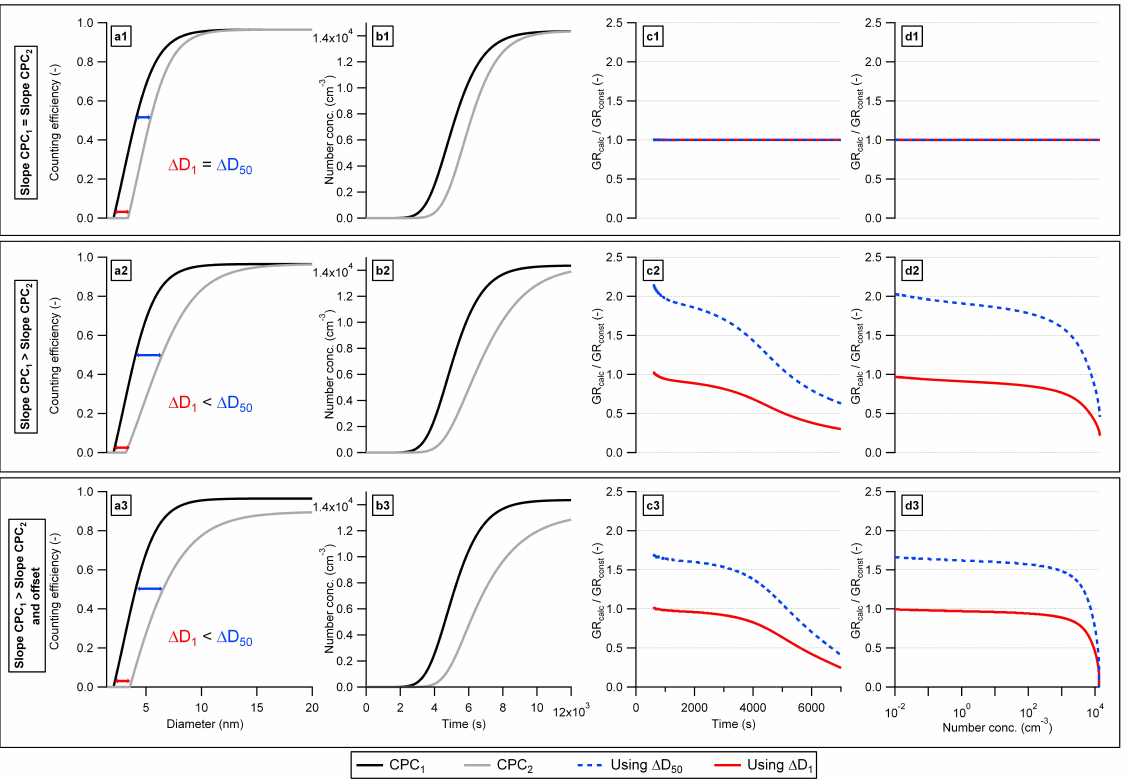
Fig. 2. Simulation of the number concentration measurement and growth rate calculation obtained using Eq. (1) and three couples of CPCs with different relations between their efficiency curves (1: Same slopes; 2: Different slopes; 3: Different slopes and offset). (a) Cutoff curves of the two CPCs. (b) Number concentration measured by the CPCs. (c) and (d) ratio between the GR calc and the actual GR const (constant value in the simulation) using the D 50 (blue dashed line) or the D 1 (red solid line) in Eq. (1) as a function of time (c) and as a function of the particle number concentration (d)